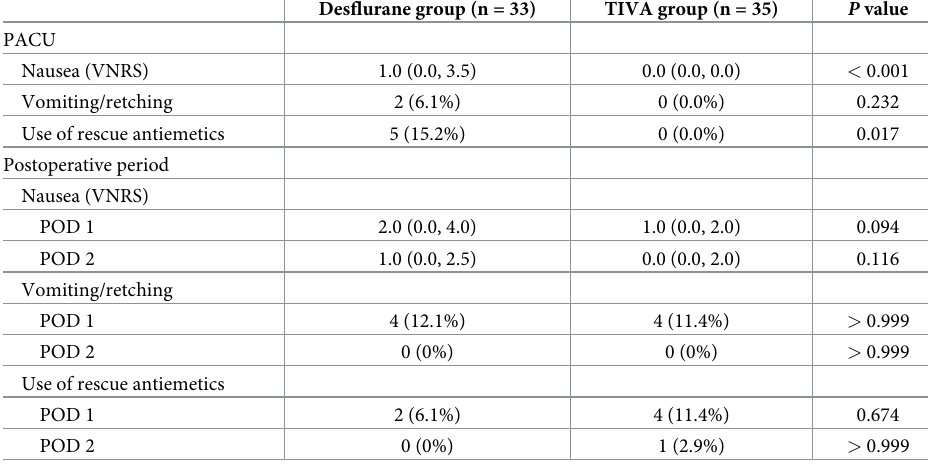
Table 3. Postoperative nausea and